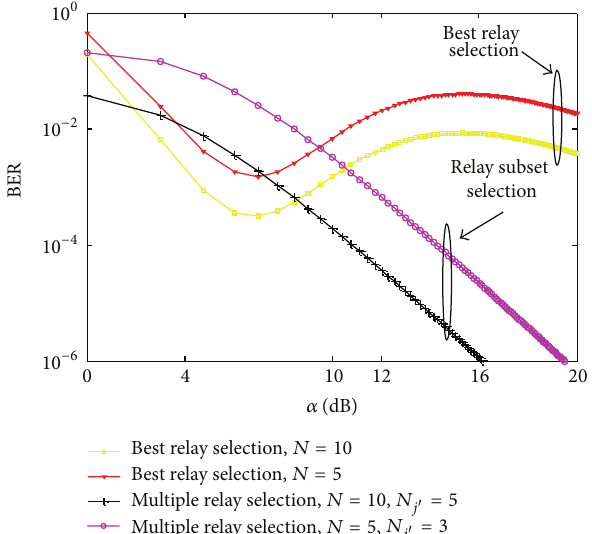
= 1 and 𝜁 = 1 for different th